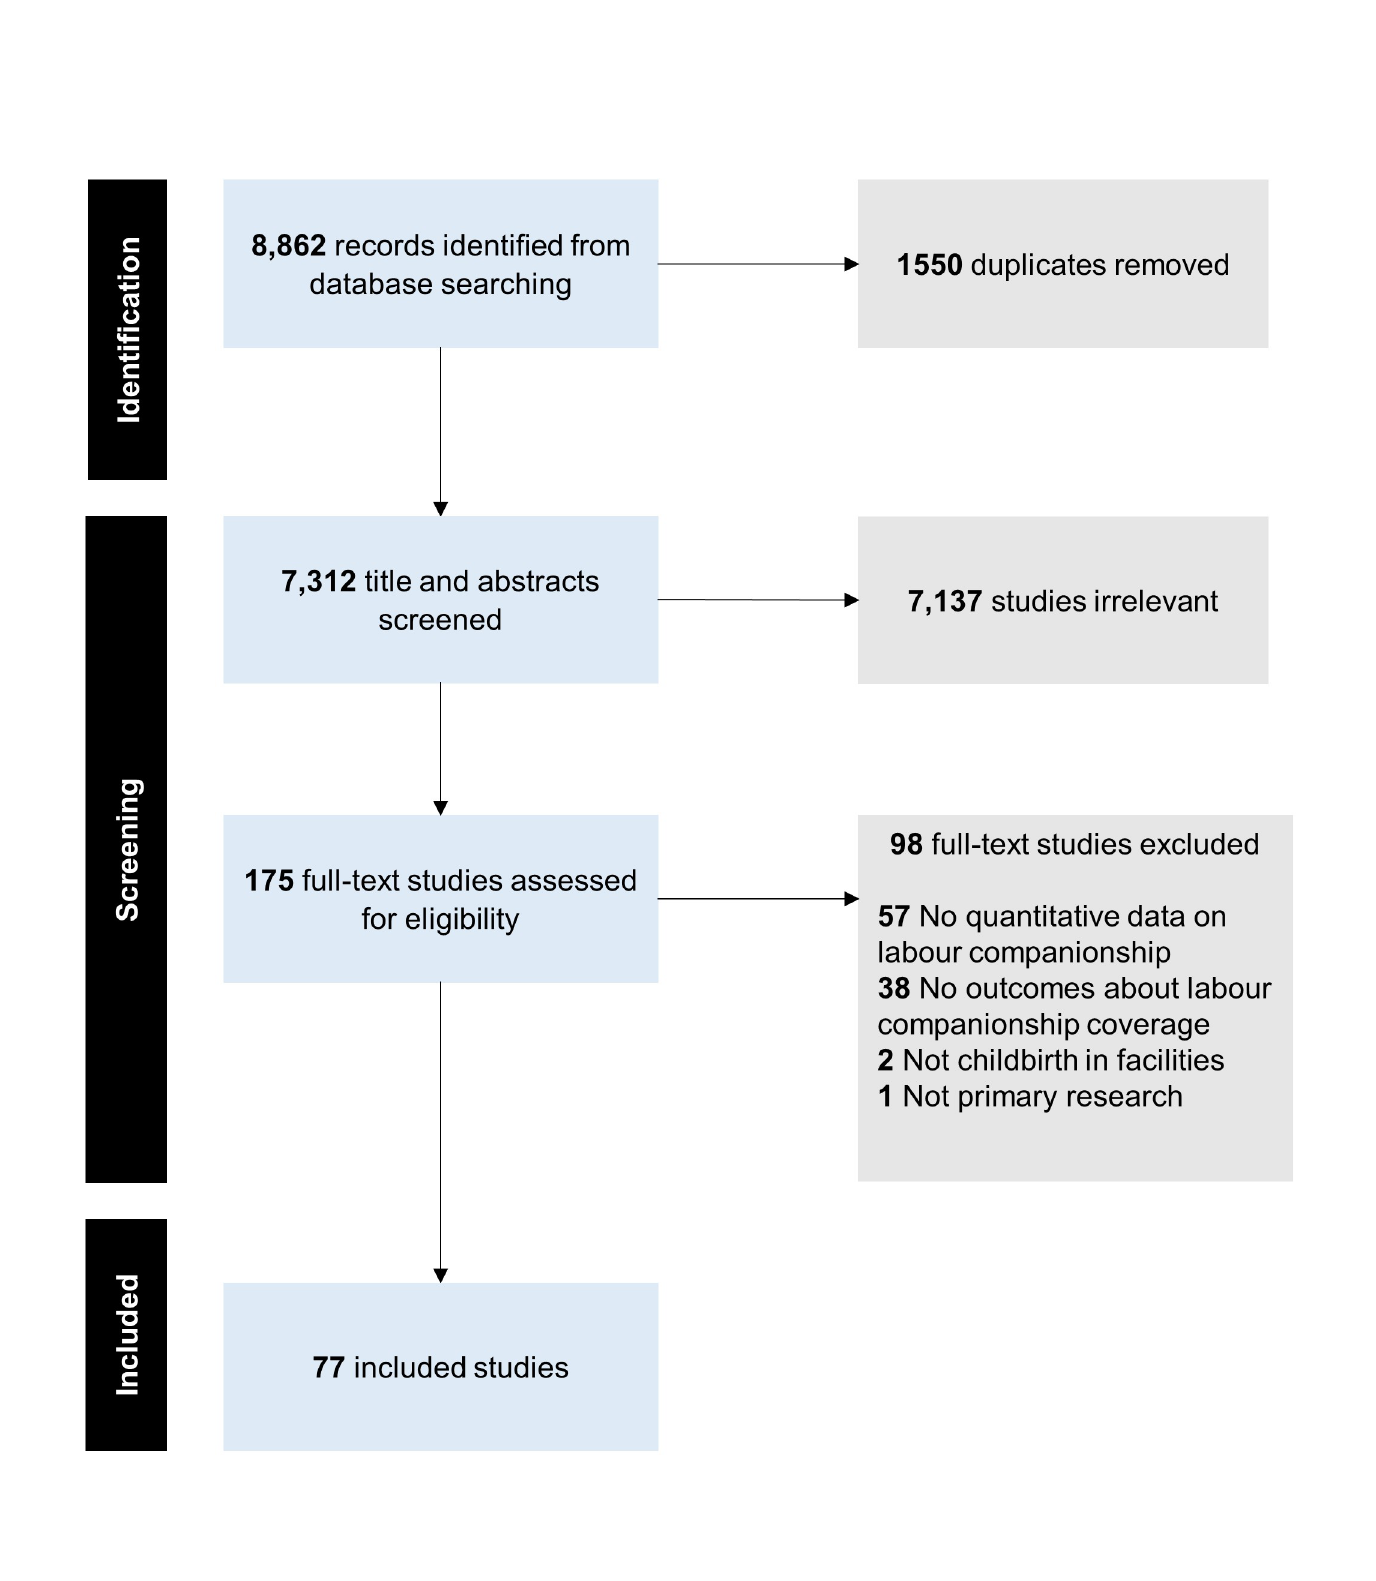
Fig 1. PRISMA flowchart depicting search and selection process. https://doi.org/10.1371/journal.pgph.0001476.g001 PLOS Global PublicHealth | https://doi.org/10.1371/journal.pgph.0001476 February 1,